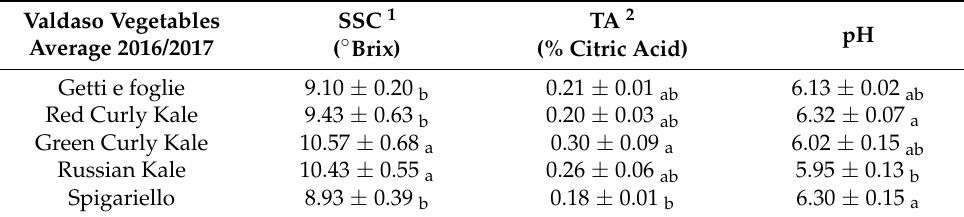
Table 4. Average of sensorial data collected during two years (2016/2017) of trials in Valdaso area. Valdaso